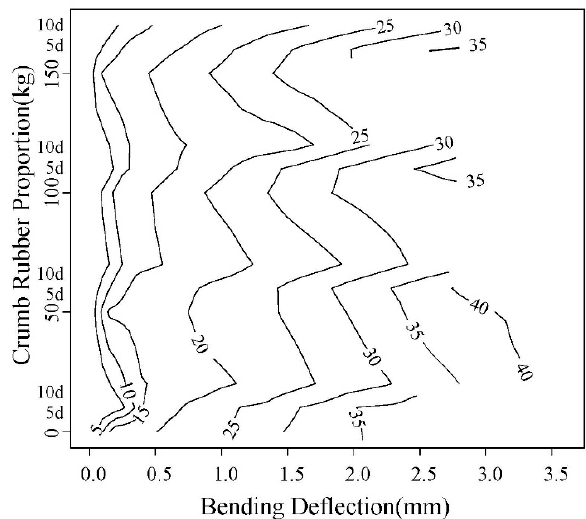
Figure 13. 0.45 Water-cement ratio load-displacement contour diagram.